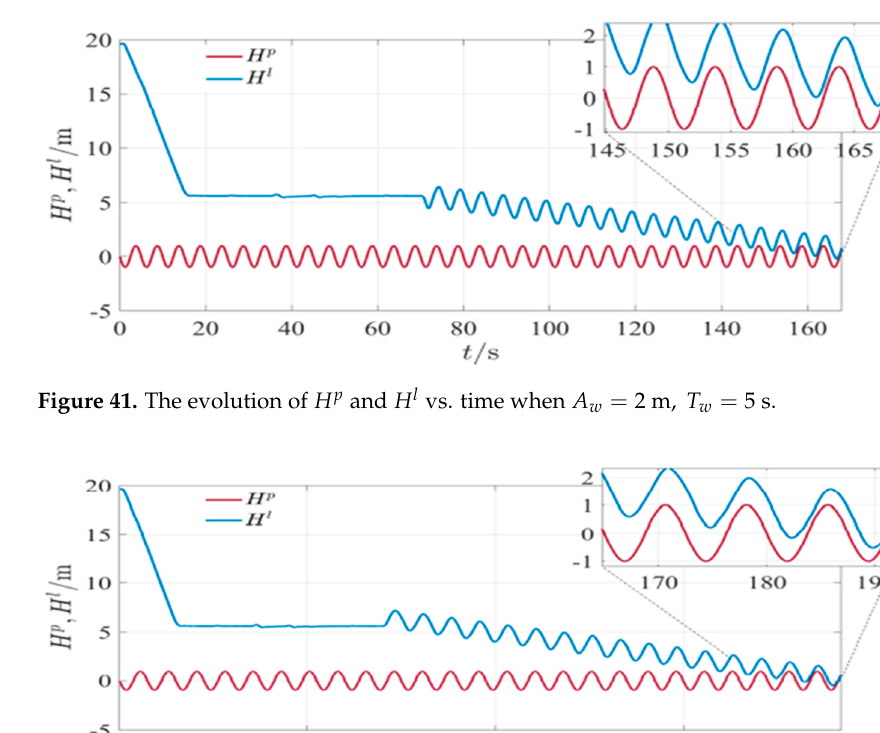
Figure 42. The evolution of H p and H l vs. time when A w = 2 m, T w = 7.5